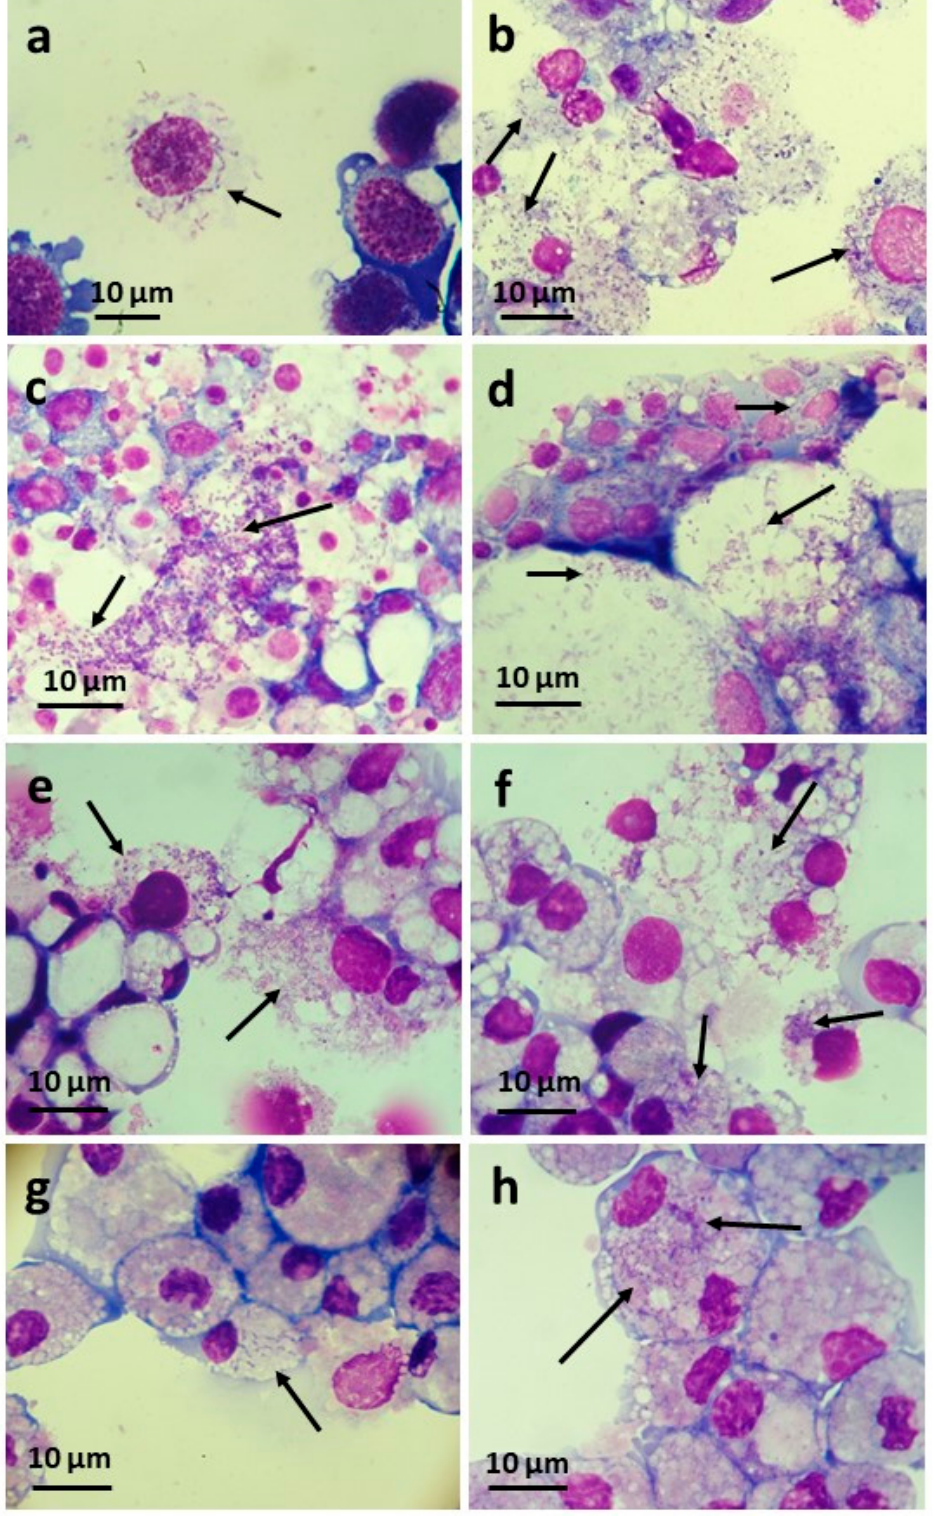
Figure 4. Wolbachia strains w Pip and w Pap (arrows) in Giemsa-stained cytocentrifuge smears of heterologous cell lines. ( a ) w Pip in Sf9 cells. ( b ) w Pip-infected C6/36 cells at passage 4. ( c ) w Pip at passage 3 in CNE/LULS44 cells. ( d ) w Pip at passage 2 in LLE/LULS45 cells. ( e ) w Pip in BME/CTVM23 cells. ( f ) w Pap in BME/CTVM23 cells. ( g ) w Pip in IRE/CTVM20 cells. ( h ) w Pap in IRE/CTVM20 cells.